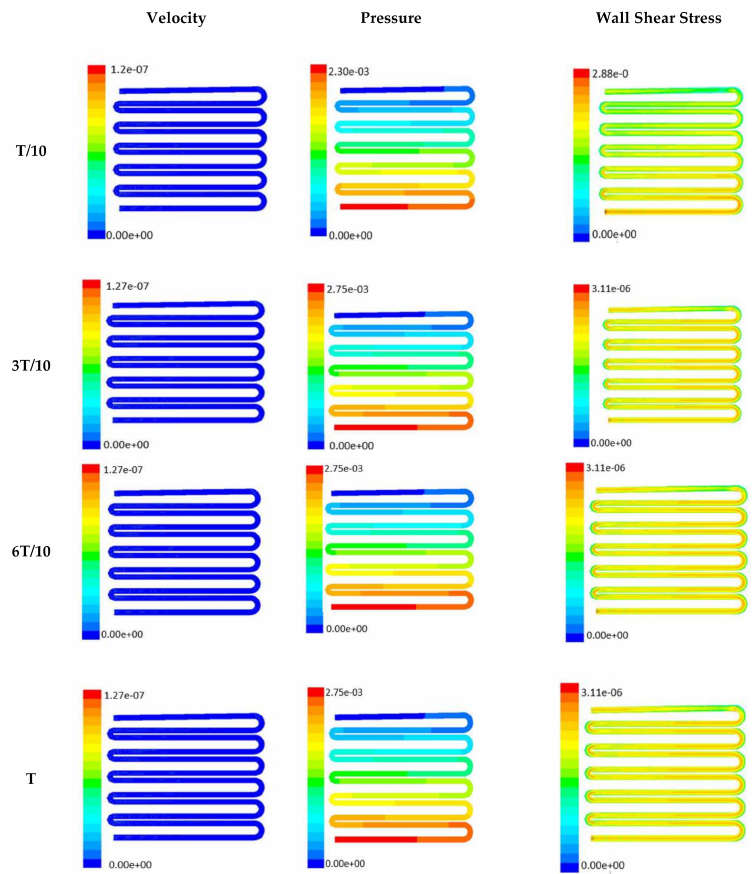
Figure 6. Numerical simulation of fluid flow inside the chip design 2 at flow rate of 5 µ L/min. The different time step was taken to understand the profile of velocity, pressure and wall shear stress along the